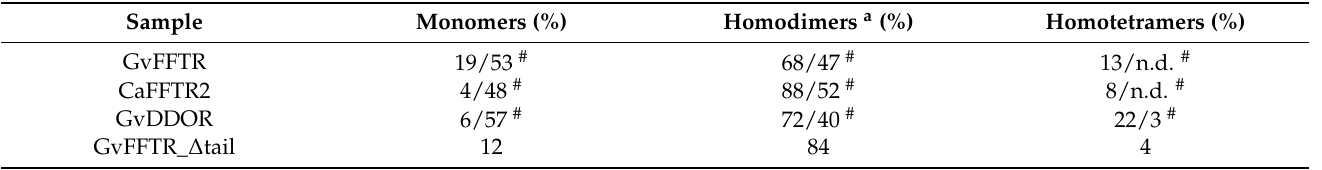
Table A3. Distribution of subpopulations identified by AFM for GvFFTR, CaFFTR2, GvDDOR, GvFFTR_ ∆ tail, GvFdx1, and GvTrxm, as well as of mixtures of FFTRs with partners (+) and when covalently attached to them (:). Samples imaged in PBS pH 7.0. Percentages refer to the total of protomers found in each association state (n = 100). # Stands for distributions in the presence of 0.1% SDS/0.2% Tween 20 detergents. n.d., not